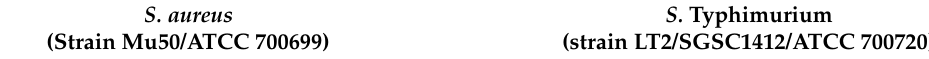
Table 7. Molecular docking results for complexes between compounds of C. sempervirens EO and protein targets of S. aureus and S. Typhimurium using Autodock Vina